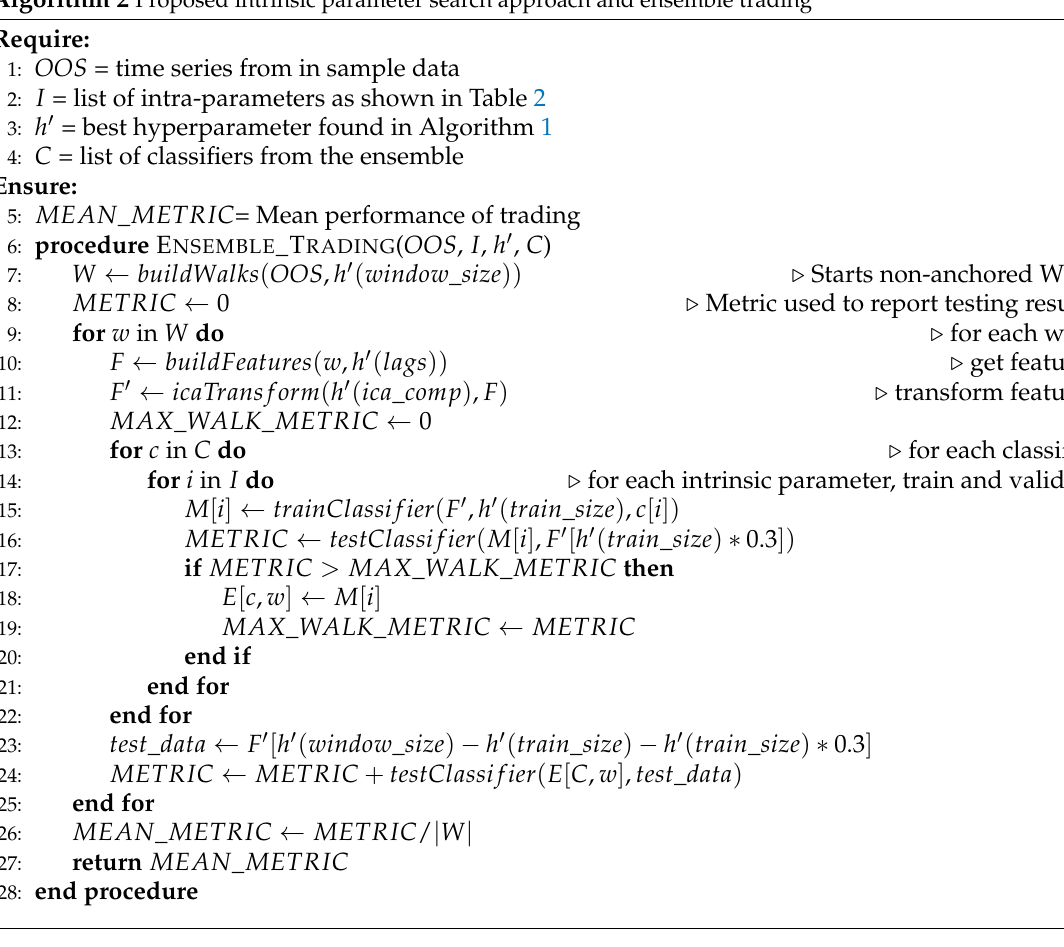
Algorithm 2 Proposed intrinsic parameter search approach and ensemble